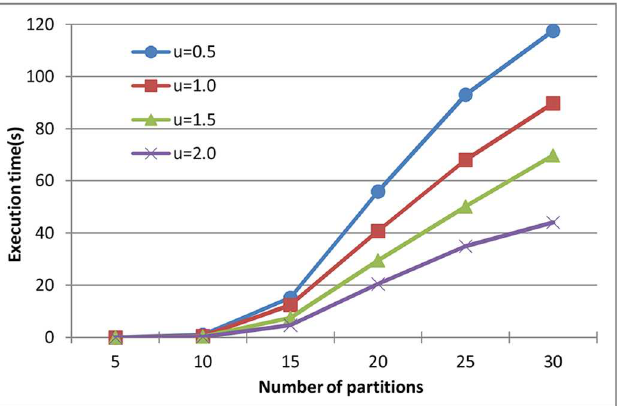
Fig 5. Time consumption of our approach on harmonic partitions generatedwith different system